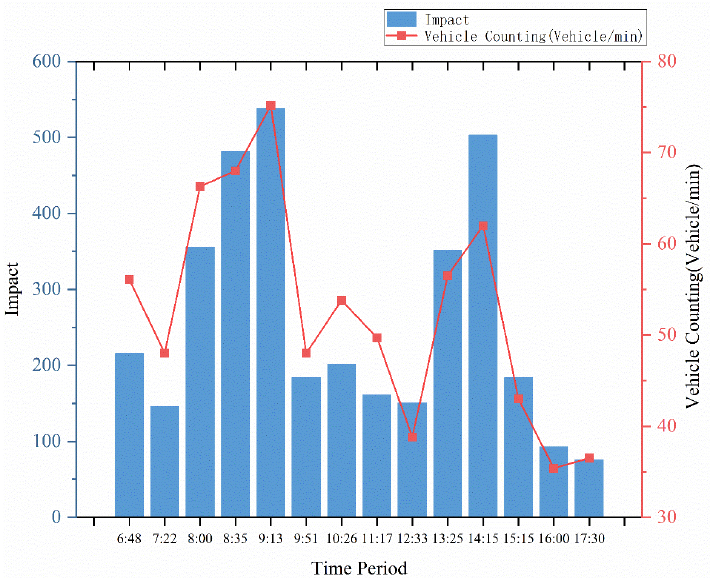
Figure 17. Noise signal impact-vehicle counting correlation diagram at position 1 of Yellow River Bridge.